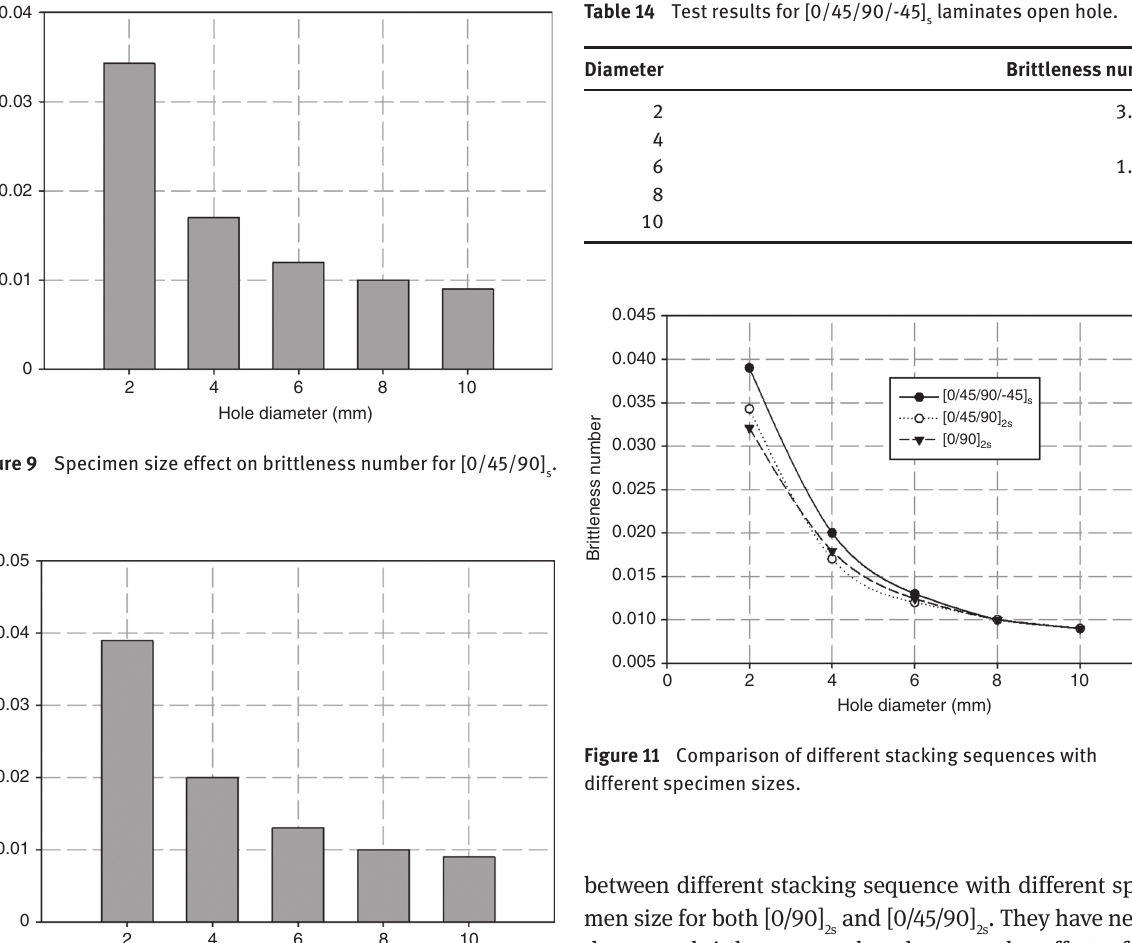
laminates open hole. 2s